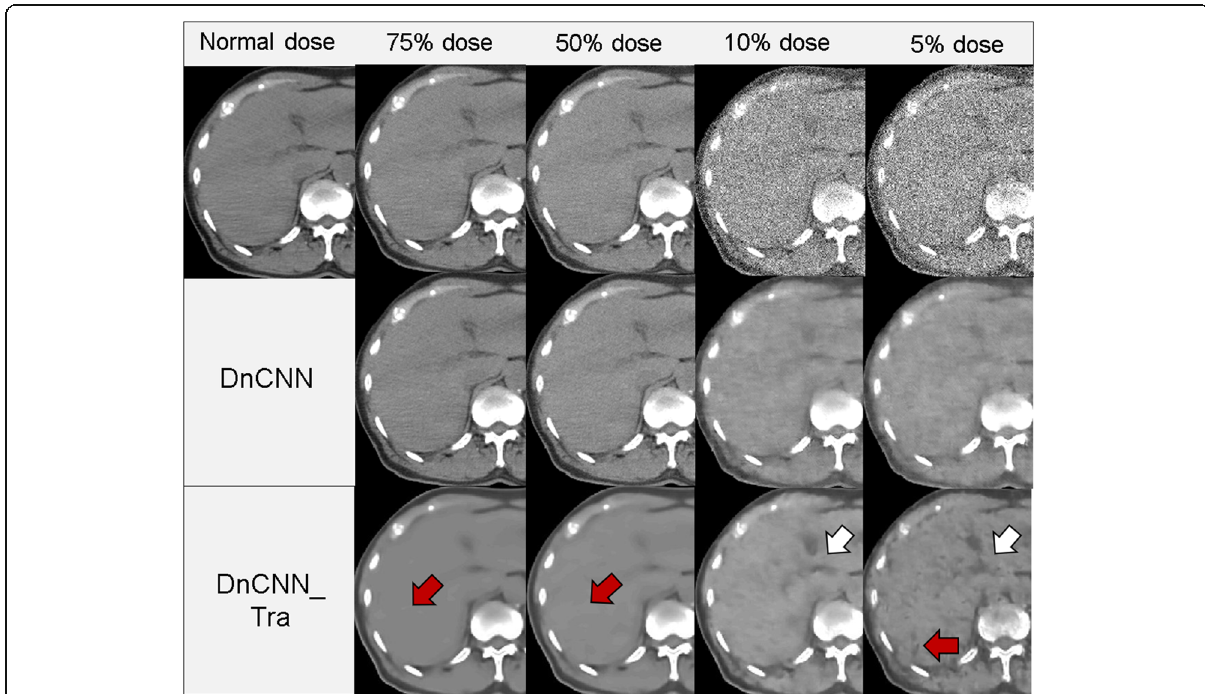
Fig. 5 Comparison of the visual inspection by denoising, between the original DnCNN and trained DnCNN methods. White arrows depict the hepatic sickle mesentery, which can be visualized by the denoising effect using the trained DnCNN method. Conversely, red arrows represent excessive smoothing triggered by the